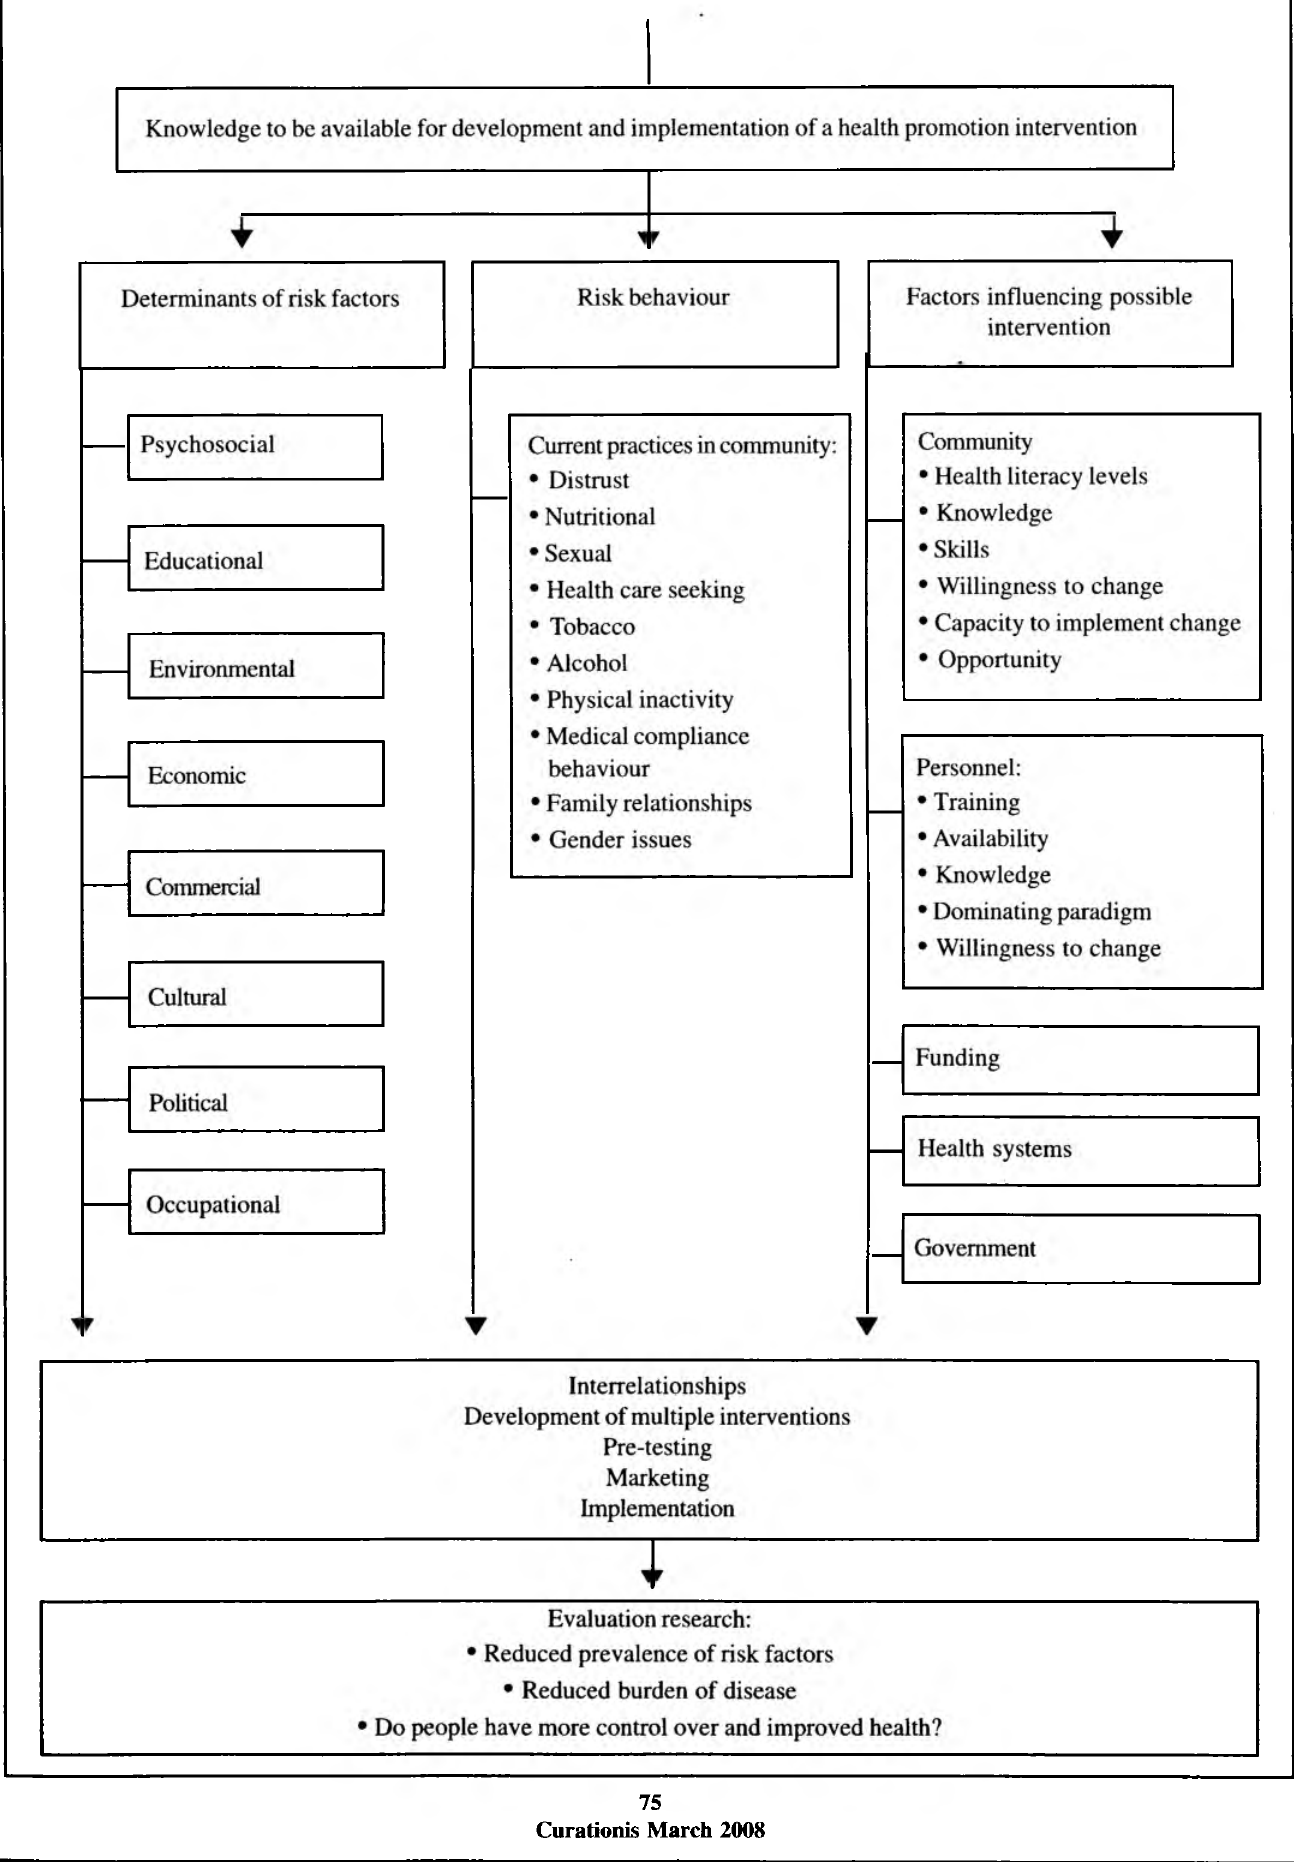
FIGURE 6: A conceptual framework to guide research to plan health promotion interventions Survey results with several life style risk factors